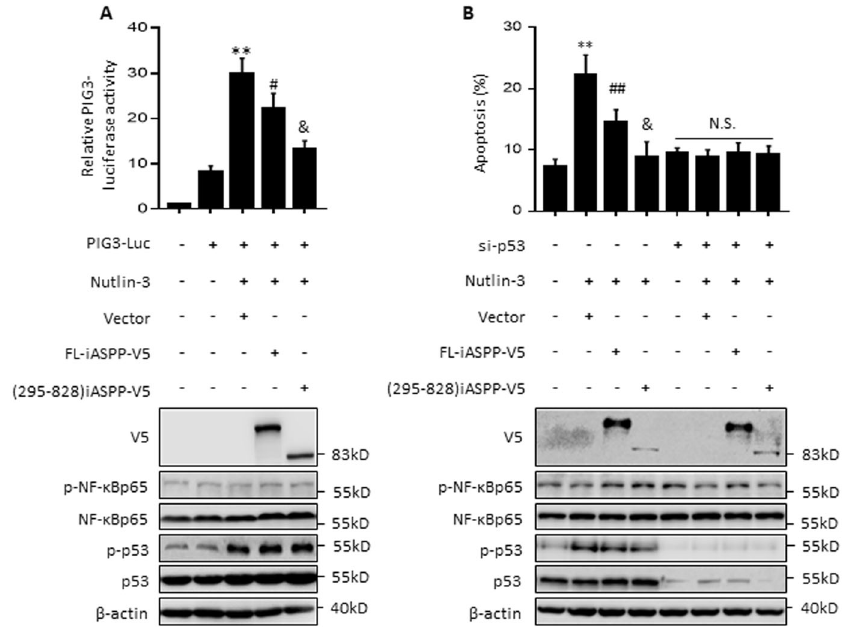
Fig. 1 iASPP fragment inhibits apoptosis in MCF-7 when p53 was activated by Nutlin-3. PIG3 luciferase activity ( A ) and apoptosis levels ( B ) were determined by the luciferase reporter assay and Annexin V-FITC and PI staining in MCF-7 cells after the indicated treatments. The PIG3 luciferase activity in cells transfected with the same amount of empty vector plasmid was normalized to 1. Relative protein levels were determined by western blot. β -actin was used as an immunoblots loading control. ** p < 0.01, relative to the untreated control; # p < 0.05 relative to the Nutlin-3-treated control; & p < 0.05 relative to Nutlin-3-treated FL control. N.S. not signi fi